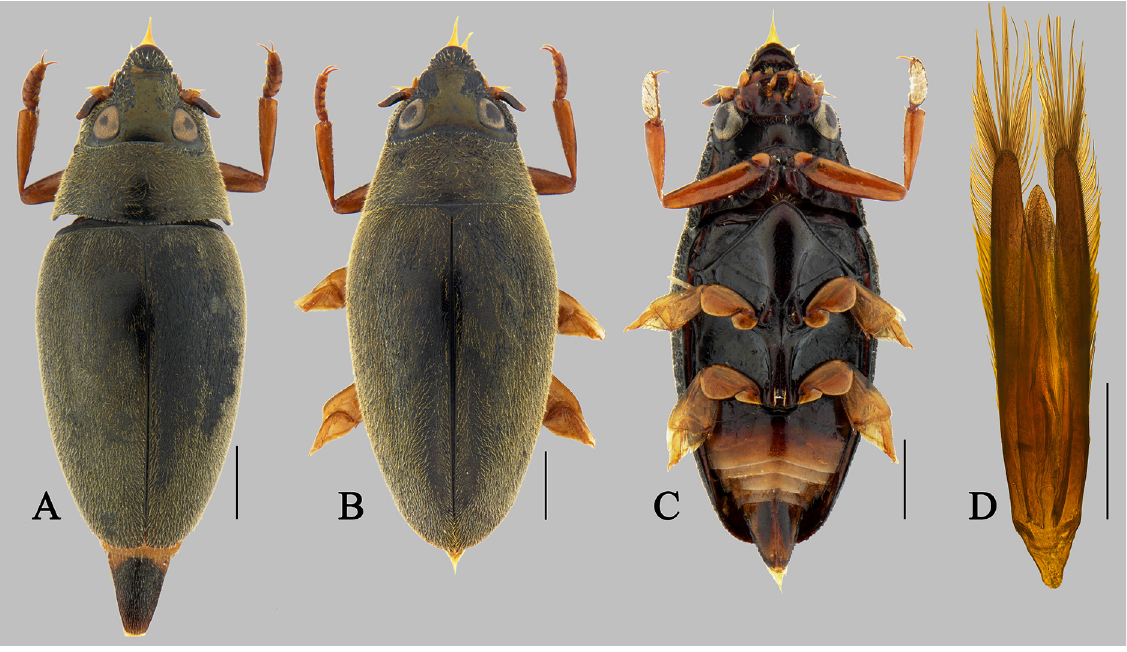
Fig. 9. Orectochilus murinus Régimbart, 1892 (SYSU). A . ♂, habitus, dorsal view. B . ♀, habitus, dorsal view. C . ♂, habitus, ventral view. D . ♂, genitalia. Scale bars: A–C = 1 mm; D = 0.5